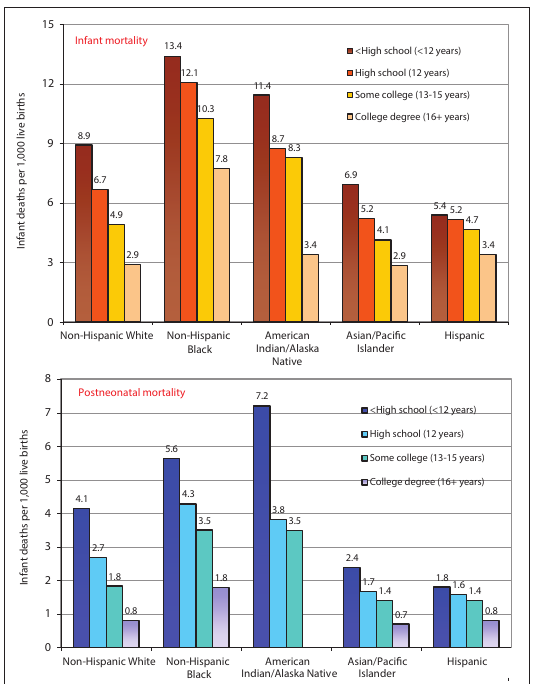
Figure 10 : Trends in Infant Mortality by Geographic Region, United States, 1969-2016 Source: US National Vital Statistics System.